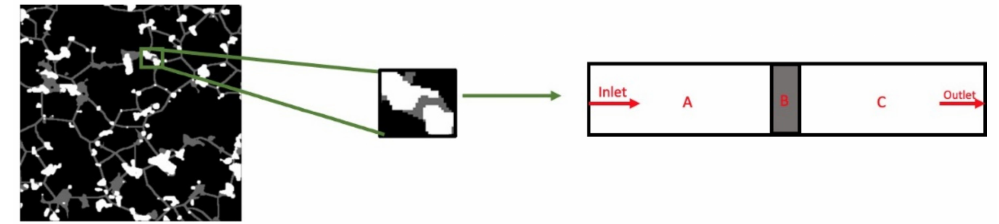
Figure 3. Schematic representation of the simulated geometry. The grey zones (Zone B) represent the low permeability zone, and the white